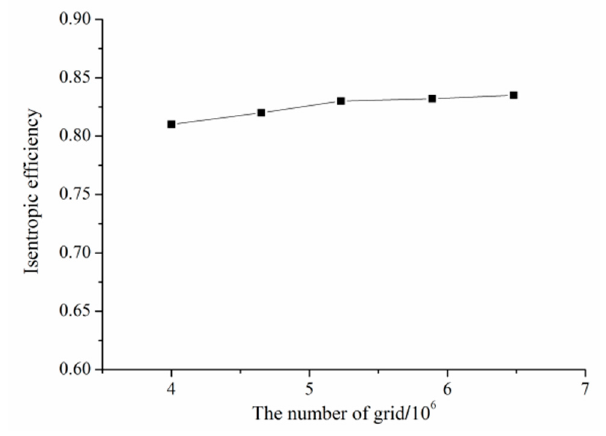
Figure 3. The grid independence verification of the centrifugal compressor.